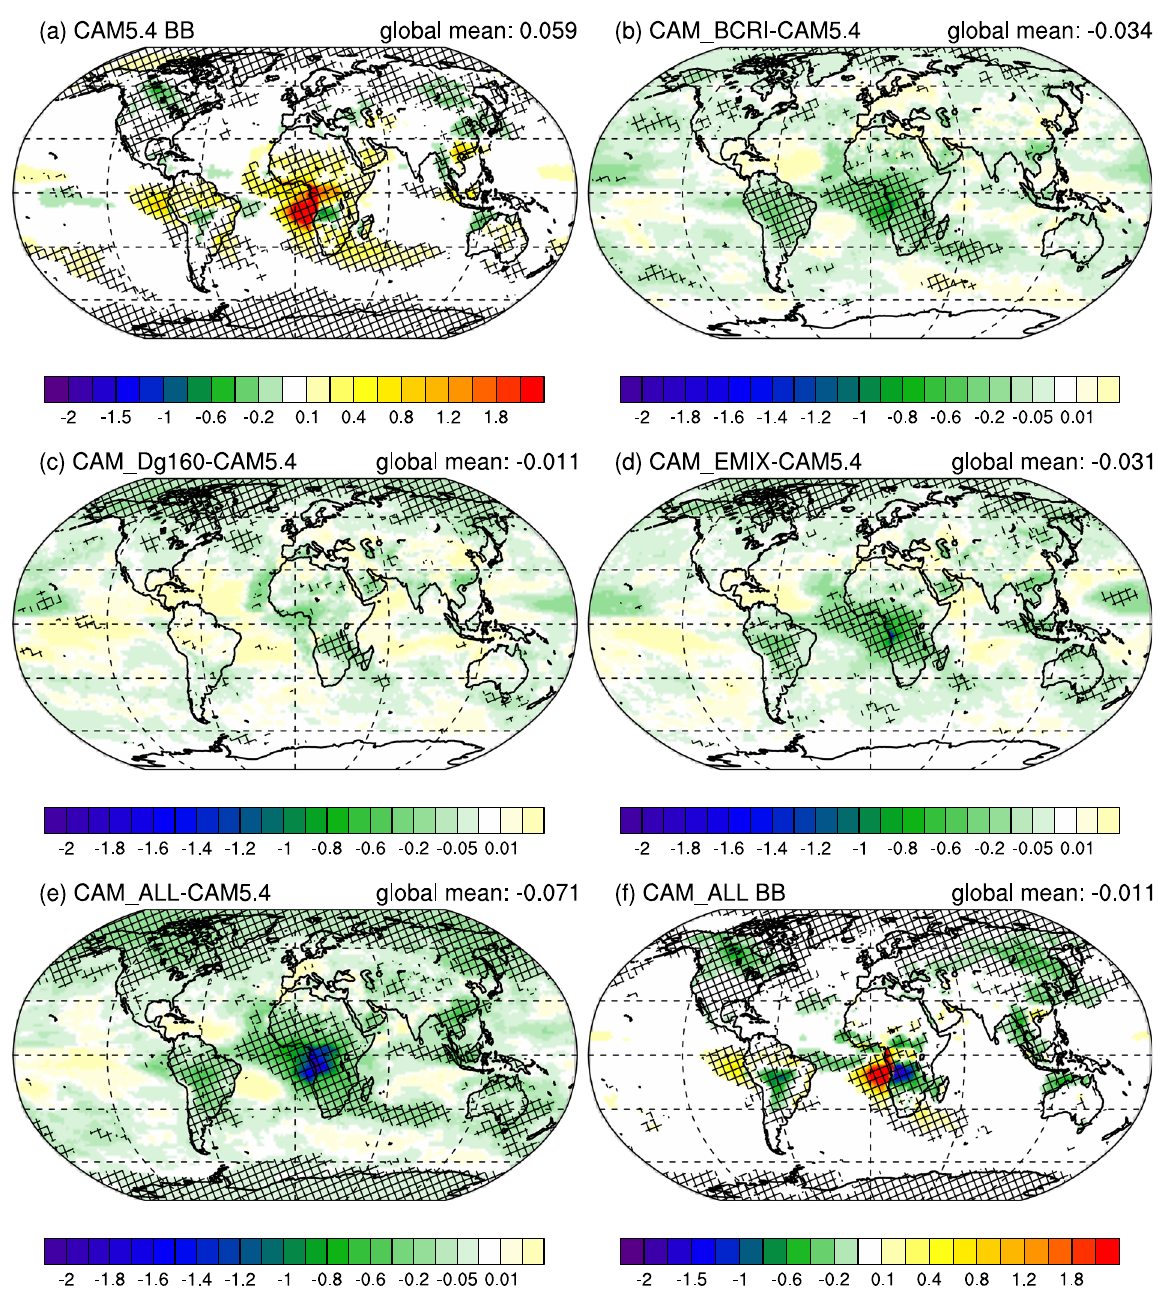
Fig. 5 Modeled radiative effect due to biomass burning aerosol-radiation interactions. a default CAM5.4 biomass burning (BB) radiative effect due to aerosol-radiation interactions (RE ari ), b the difference in RE ari due to changes in BB black carbon refractive index (CAM_ BCRI – CAM5.4), c the difference in RE ari due to increasing BB aerosol size (CAM_Dg160 – CAM5.4), d the difference in RE ari due to treating fresh BB aerosol as externally mixed (CAM_EMIX – CAM5.4), e the difference in RE ari due to all of the previous changes (CAM_ALL – CAM5.4), and f the RE ari of BB with all of the previous changes (CAM_ALL). Hatching indicates regions where the change over the ensemble years is signi fi cant to the 0.05 level. Note difference in color